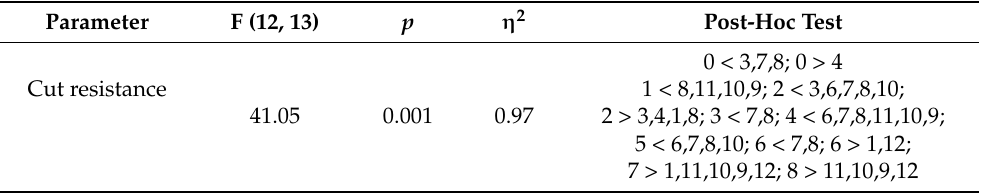
Table 4. ANOVA statistics for the effects of the studied additives on cut